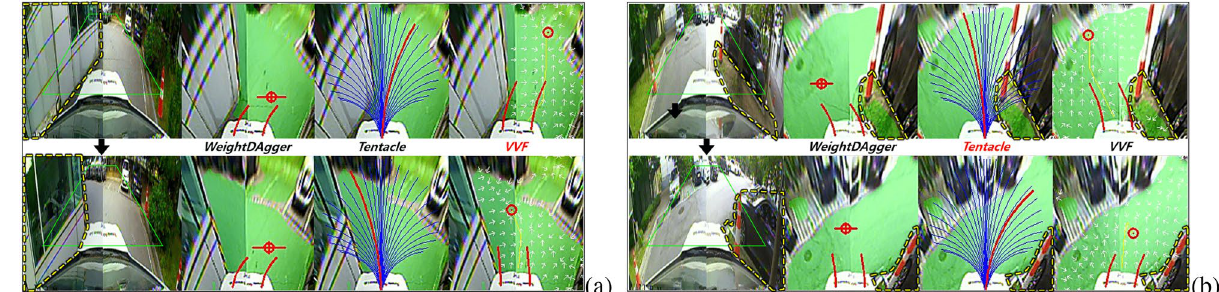
Figure 13. Problems for driving in narrow drivable area with large curvature changes: ( a ) VVF , ( b ) Tentacle .